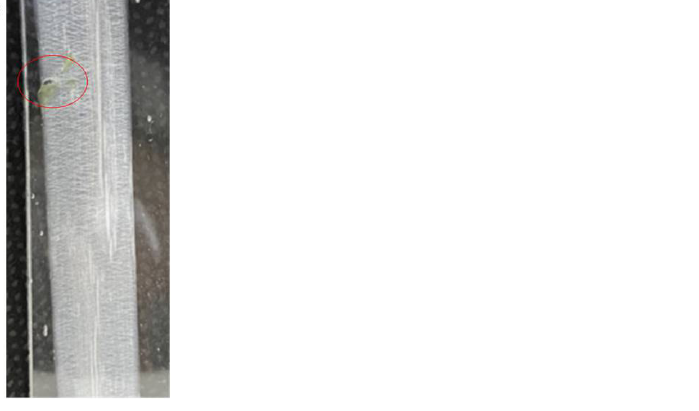
Figure 11. ( a ) Sensor angle at 0°; ( b ) The sensor angle at 35°; the red circle is where the PVDF fiber breaks.